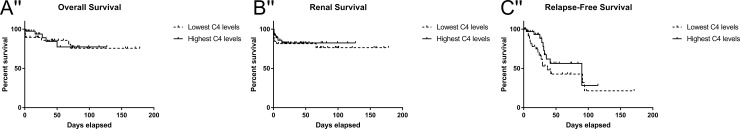
Kaplan-Meier estimate of overall (A''), renal (B'') and relapse-free (C'') survival rates in patients with granulomatosis with polyangiitis or microscopic polyangiitis, according to the low normal or high normal plasma C4 levels (relative values) performed before treatment, based on the median value of C4 levels observed in the whole cohort (p = 0.83, 0.69 and 0.20, respectively).